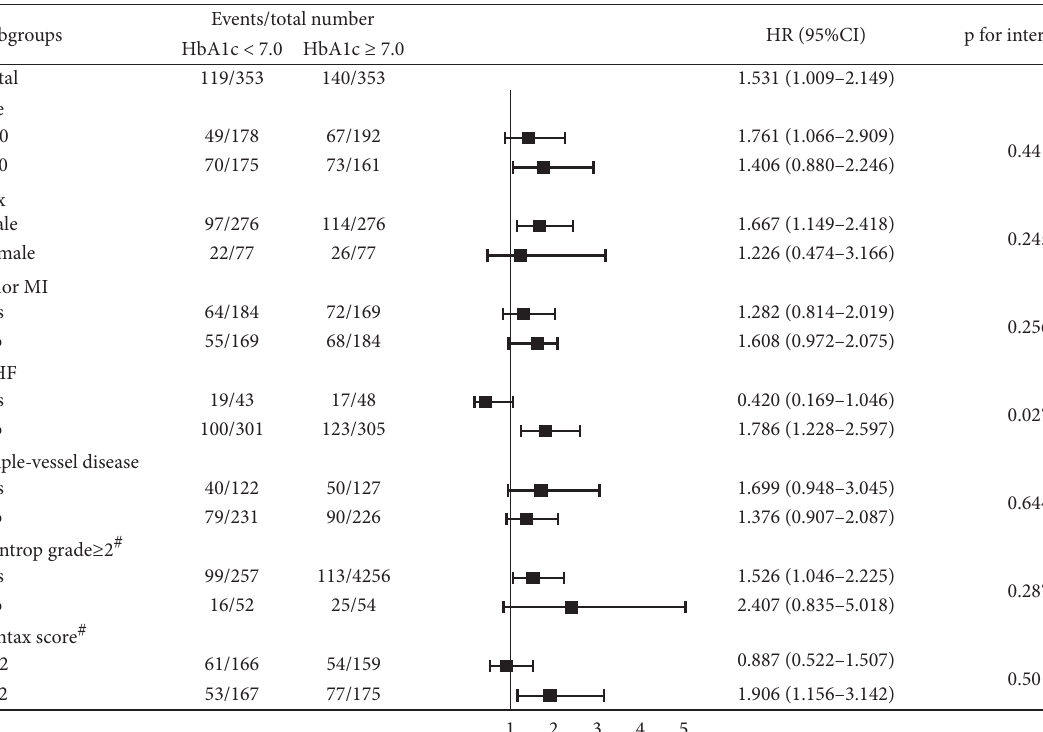
Figure 5: Comparative adjusted hazard ratios of the primary outs between the HbA1c < 7.0 group and the HbA1c ≥ 7.0 group for each subgroup in the propensity score-matched population. HR: hazard ratio; CI: conference interval; CHF: chronic heart failure; MI: myocardial infarction. #Cine angiogram records got from 906 (88.05%)